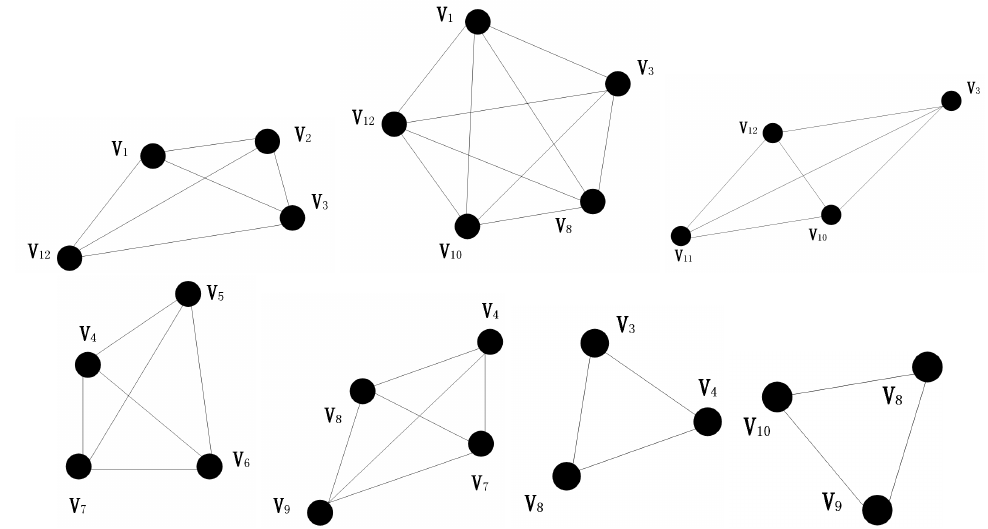
Figure 2. These seven graphs show the results of the division of factions after all nodes in the network have been